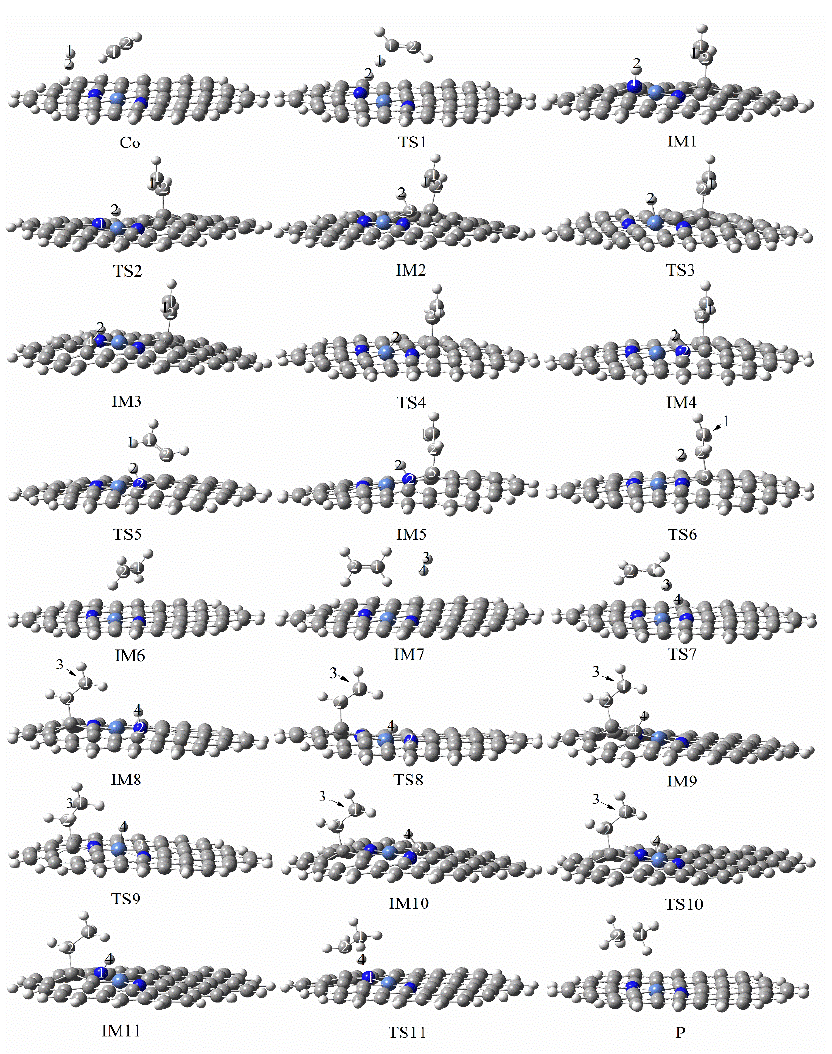
Figure 9. Optimal reaction pathway for acetylene hydrogenation catalyzed by graphene-NiN 2 (B) catalyst.